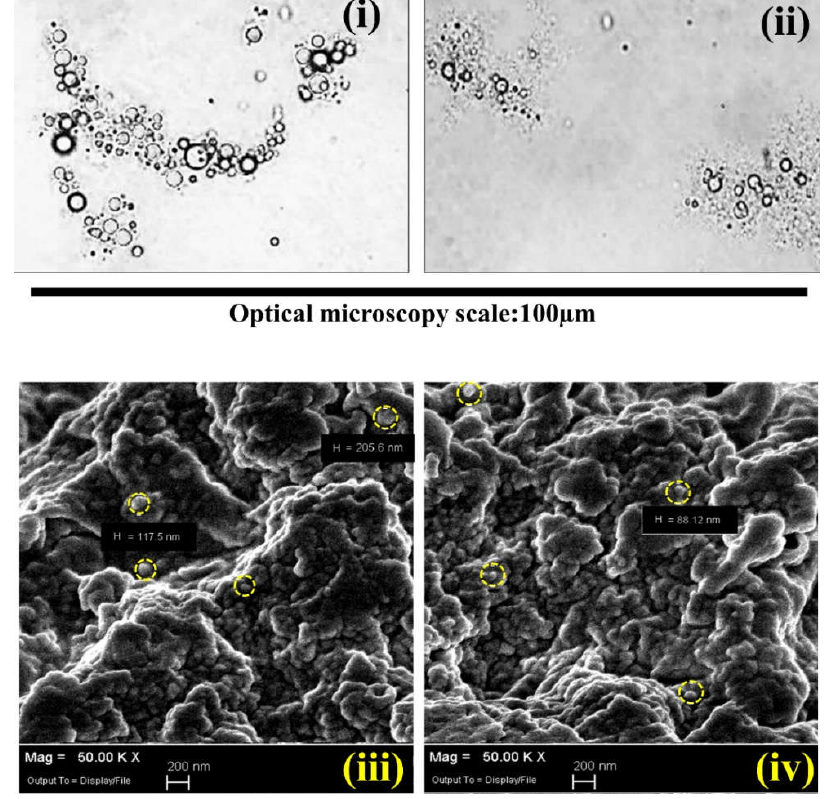
Figure 8. Optical microscopic images of crosslinked microcapsules with GTA. ( i ) 0.3 g and ( ii ) 0.6 g GTA per unit gram (g) of total biopolymer; SEM images of crosslinked microcapsules with ( iii ) 0.3 g GTA and ( iv ) 0.6 g per unit gram of total biopolymer. “H” indicates the diameter in nanometer unit (nm); the yellow circles indicate the typical spherical microcapsules in the aggregates.